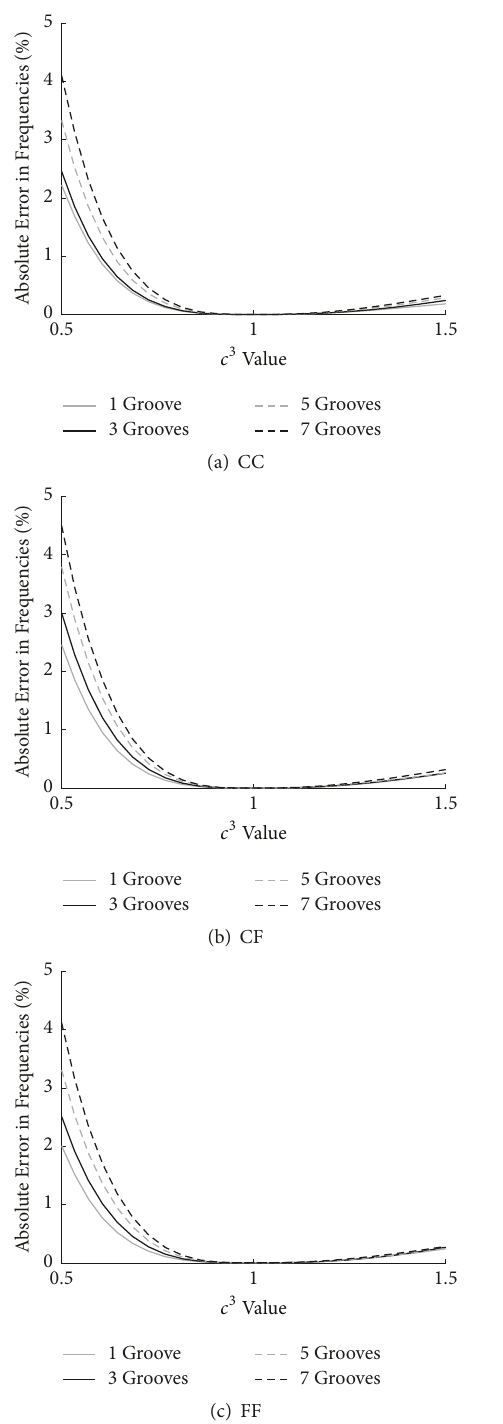
Figure 9: Frequency error results for variable 𝑐 using the second- order gradient minimization.